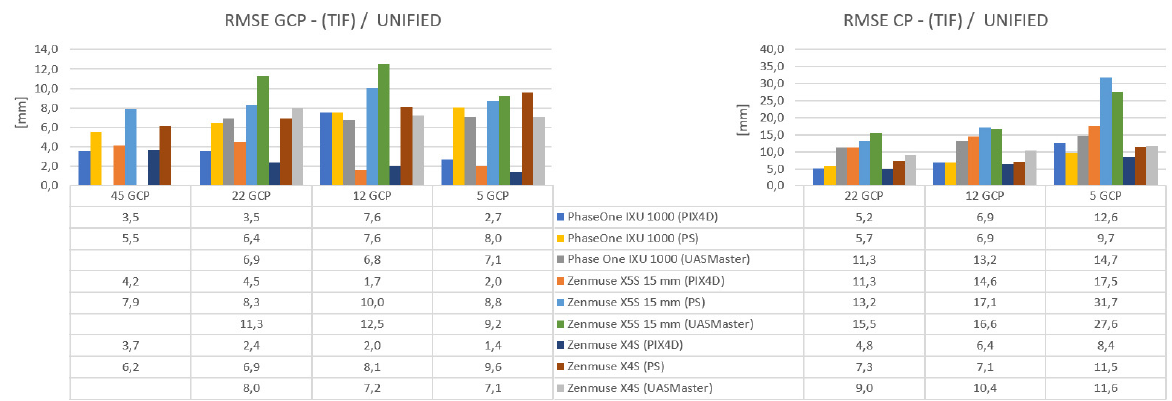
Figure 10. Comparison of the 3D RMSE values at GCPs (left) and CPs (right) as results of the bundle block adjustments with Pix4Dmapper, Agisoft PhotoScan and Inpho UASMaster. Note